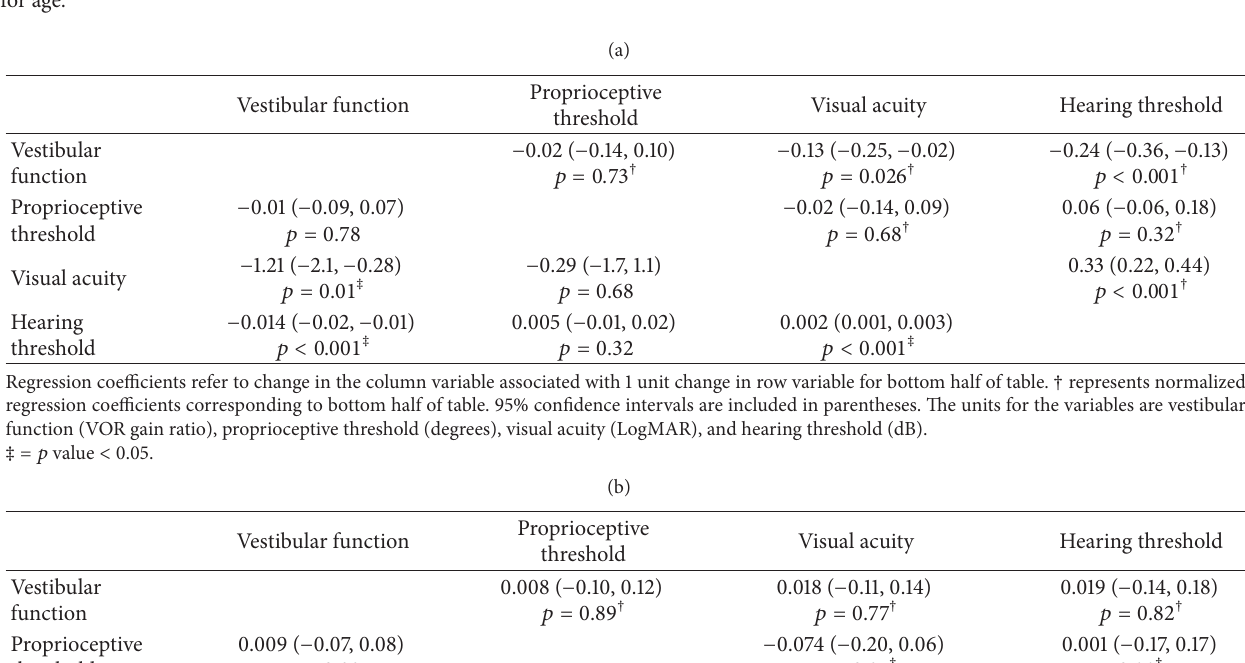
Table2:(a)Bivariateassociationsbetweenperipheralsensorysystems.(b)Bivariateassociationsbetweenperipheralsensorysystemsadjusted for age.